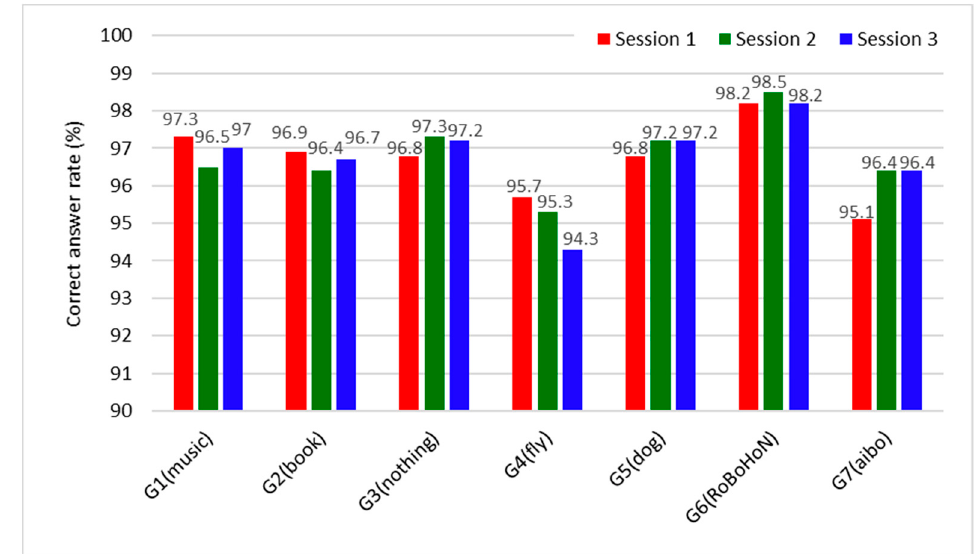
Figure 5. Average correct-answer rate for each session in groups.